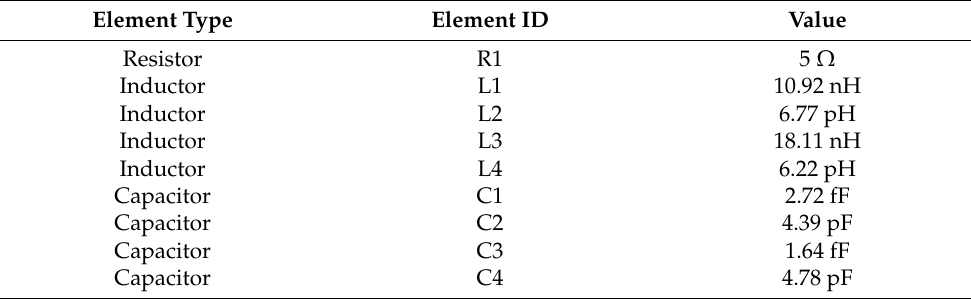
Table 1. Values of the simulated filter